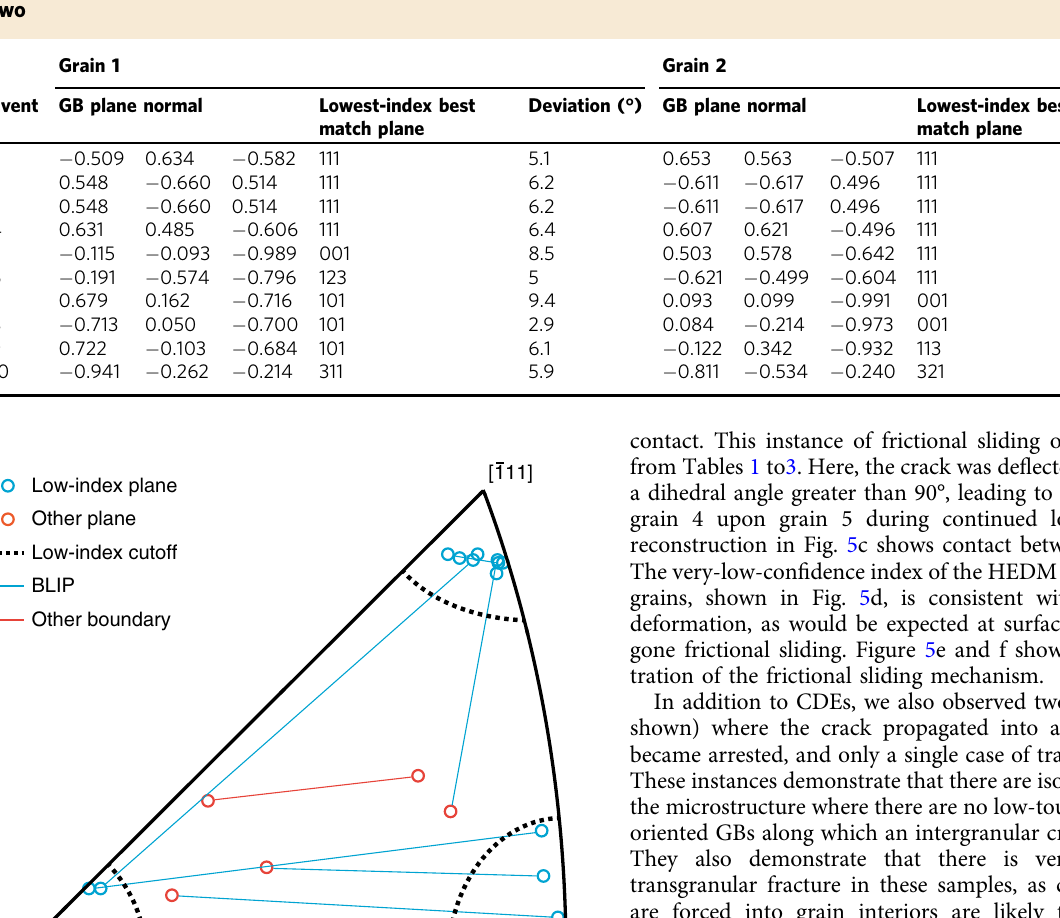
Table 3 Plane normal directions for the crack-resistant GB in each CDE, provided in the Nye frames of both adjoining grains. Lowest-index Miller planes that best match each GB plane are given along with the angle describing the deviation between the